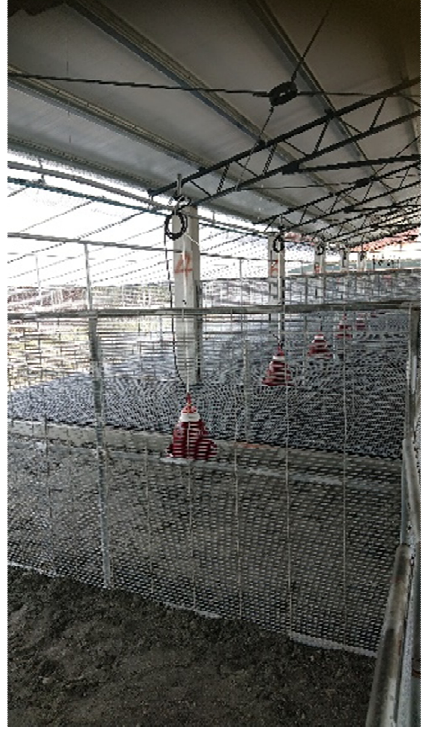
Figure 1. The indoor goose house set-up in this experiment. Water was provided by red narrow-lip bell drinkers. Pens were separated using wire meshes. A plastic greenhouse film was placed on top of the pool to provide natural light. The roof above the feeding and resting areas was also covered with polyurethane foam sandwich panels to prevent geese from interacting with wild birds.